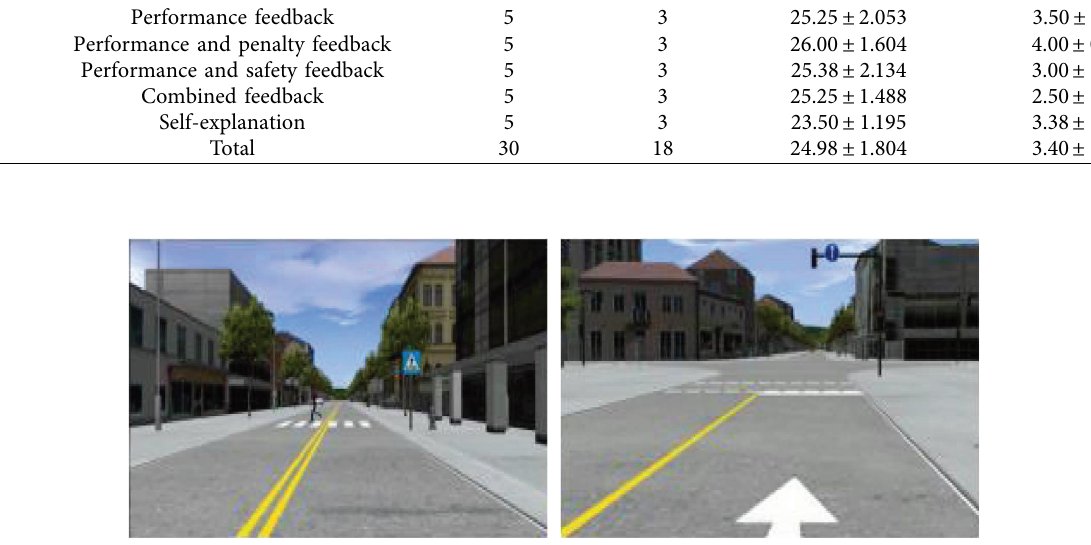
Figure 2: Screenshot of critical